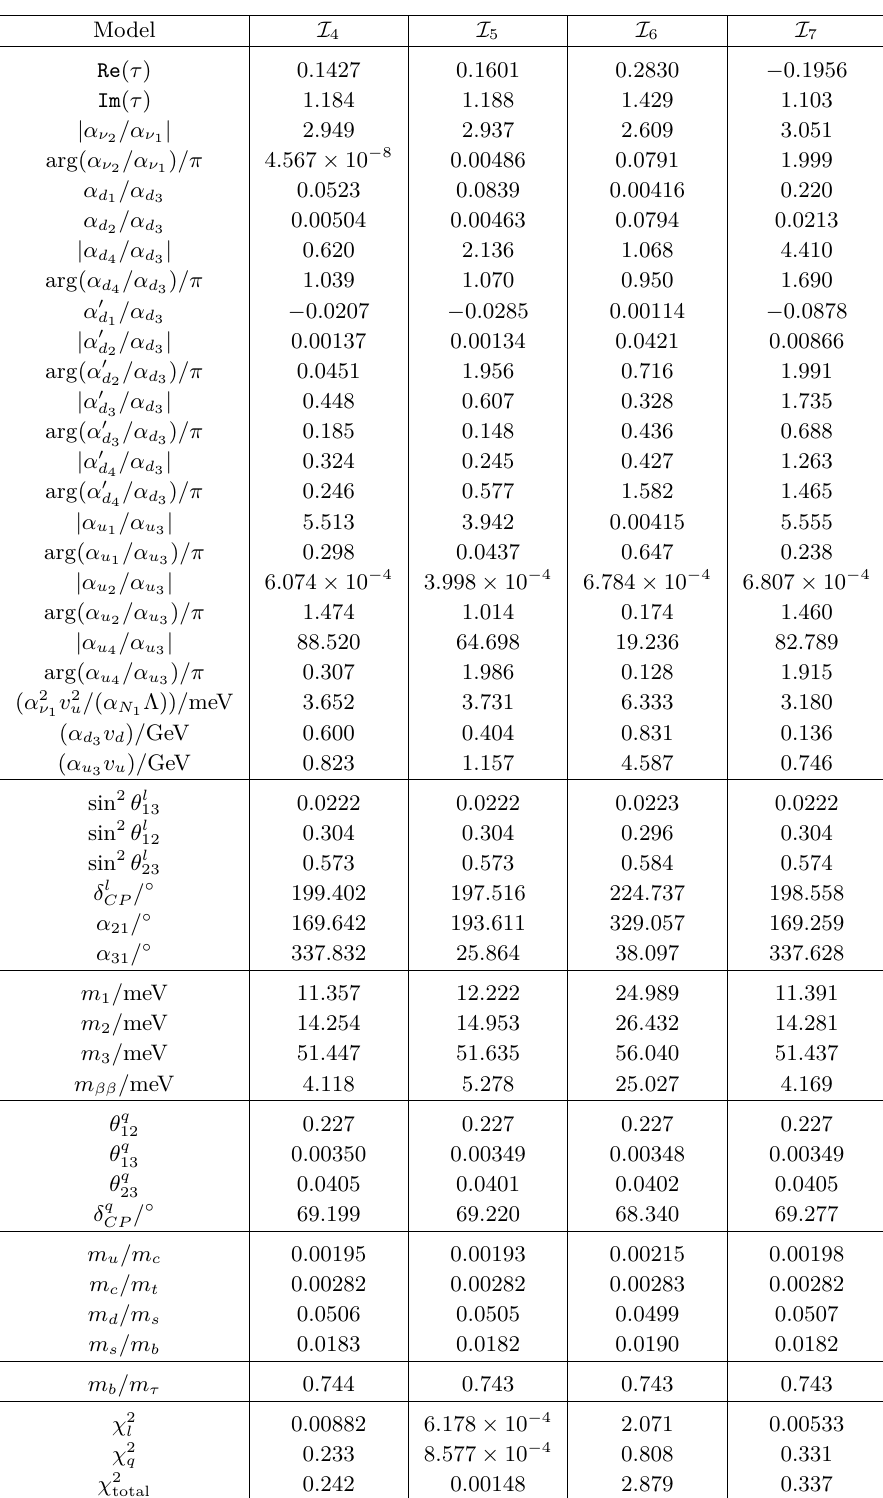
Table 5 . The best fit values of the free parameters and the corresponding predictions for lepton and quark mixing parameters and fermion masses for the phenomenologically viable models of Type-I (continuation of table